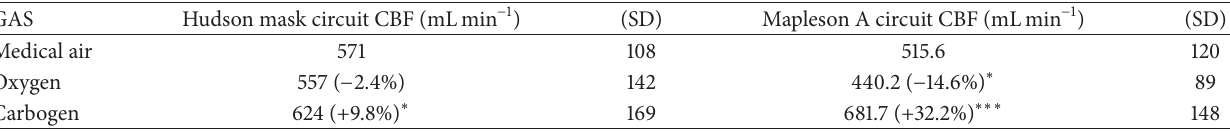
Figure 2: Box plot (median, quartiles) of CBF results under each gas. Hudson Mask circuit = reservoir bag mask, Mapleson A = semi-open anaesthetic circuit. Table 2: CBF results are shown for both circuits and each